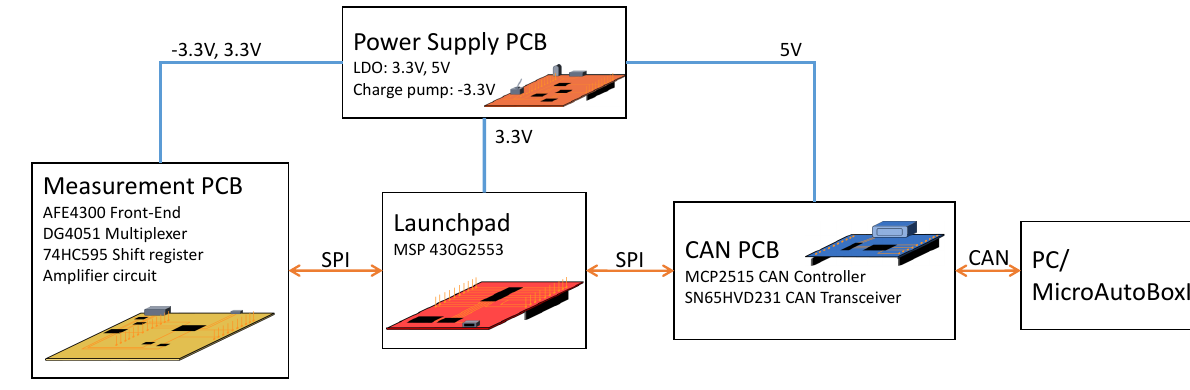
Fig.2: Schematic overview of the modular layout of the impedance measurement